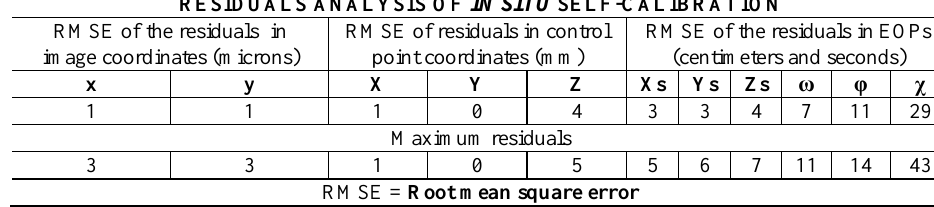
Table 2. Main results of the residuals analysis of the self-calibration bundle adjustment of the first sub block